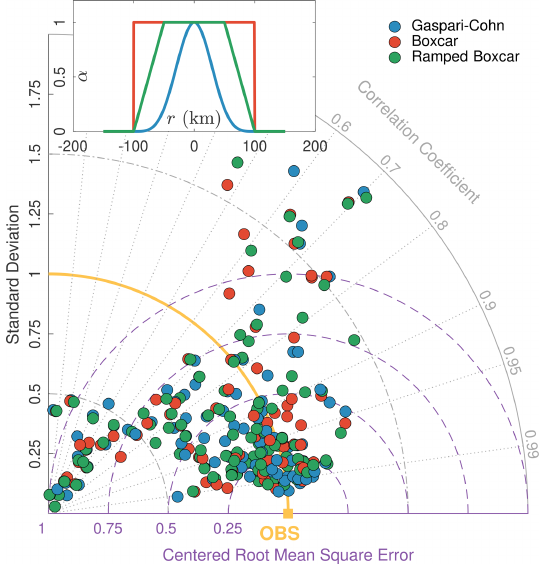
Figure 6. Taylor diagram for hourly prior streamflow estimates using ATS localization with three different correlation functions, namely Gaspari–Cohn, boxcar, and ramped boxcar. The localiza- tion radius is set to 100km. The shape of the functions is compared at the top of the plot. Ramped boxcar decays linearly to 0, starting at half-width (i.e., 50km) distance from the observation. Compar- isons to all gauges in the domain are performed; however, estimates with high errors and standard deviations, resulting from boxcar and ramped boxcar, are not shown for